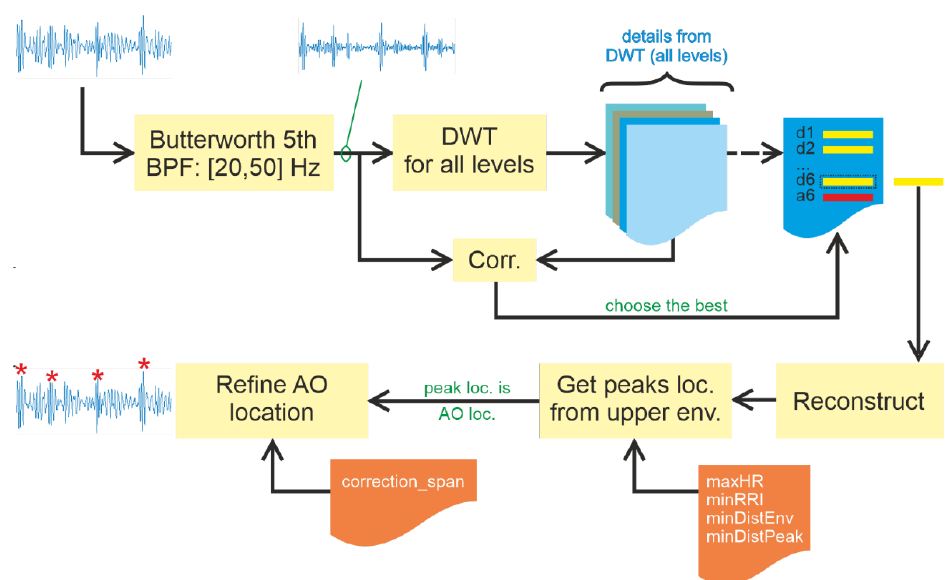
Figure 5. Both signal enhancement and Algorithm #2 presented as a block diagram. The asterisks in the figure represent the detected AO from the algorithm.